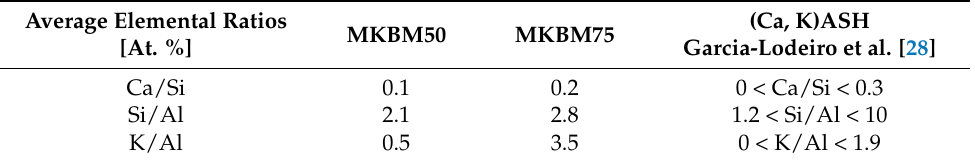
Table 3. Elemental ratio composition of the geopolymer composites by EDS analysis (averaged on 4 analysis points). Data are reported net of an error of